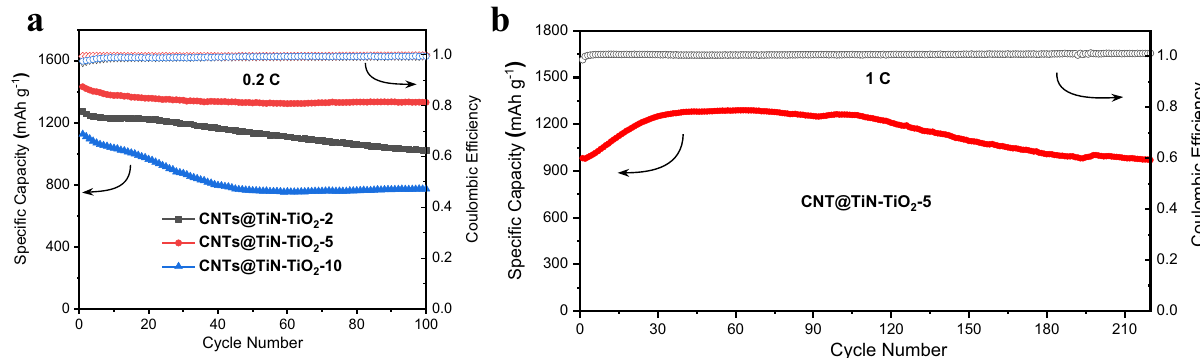
Fig. 6 Cycling performance of CNTs@TiN – TiO 2 -2, CNTs@TiN – TiO 2 -5, and CNTs@TiN – TiO 2 -10. a Cyclic stability comparison of CNTs@TiN – TiO 2 -2, CNTs@TiN – TiO 2 -5 and CNTs@TiN – TiO 2 -10 after 100 cycles at 0.2 C. b Long-term cycling performance of CNTs@TiN – TiO 2 -5 at 1 C. Source data